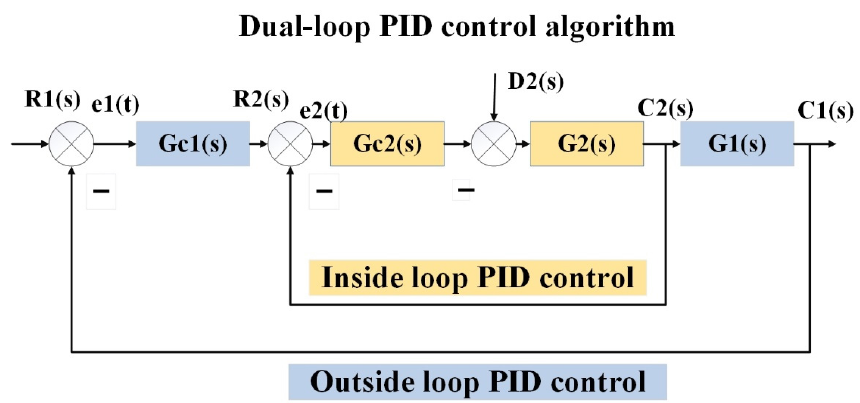
Figure 2. The basic model of the Dual-loop PID control algorithm.